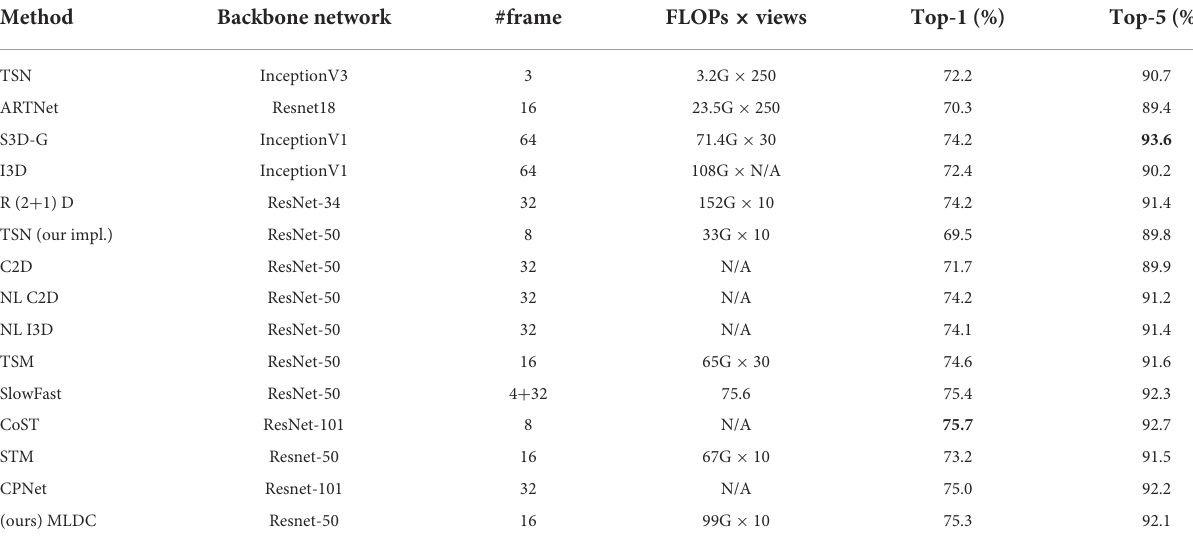
TABLE 5 Comparison of the MLDC algorithm with the current optimal algorithm.